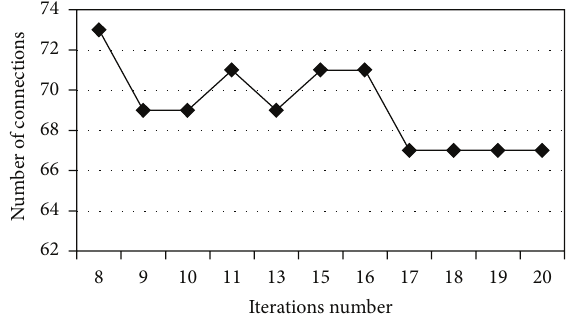
Figure 8: Minimization of energy level.